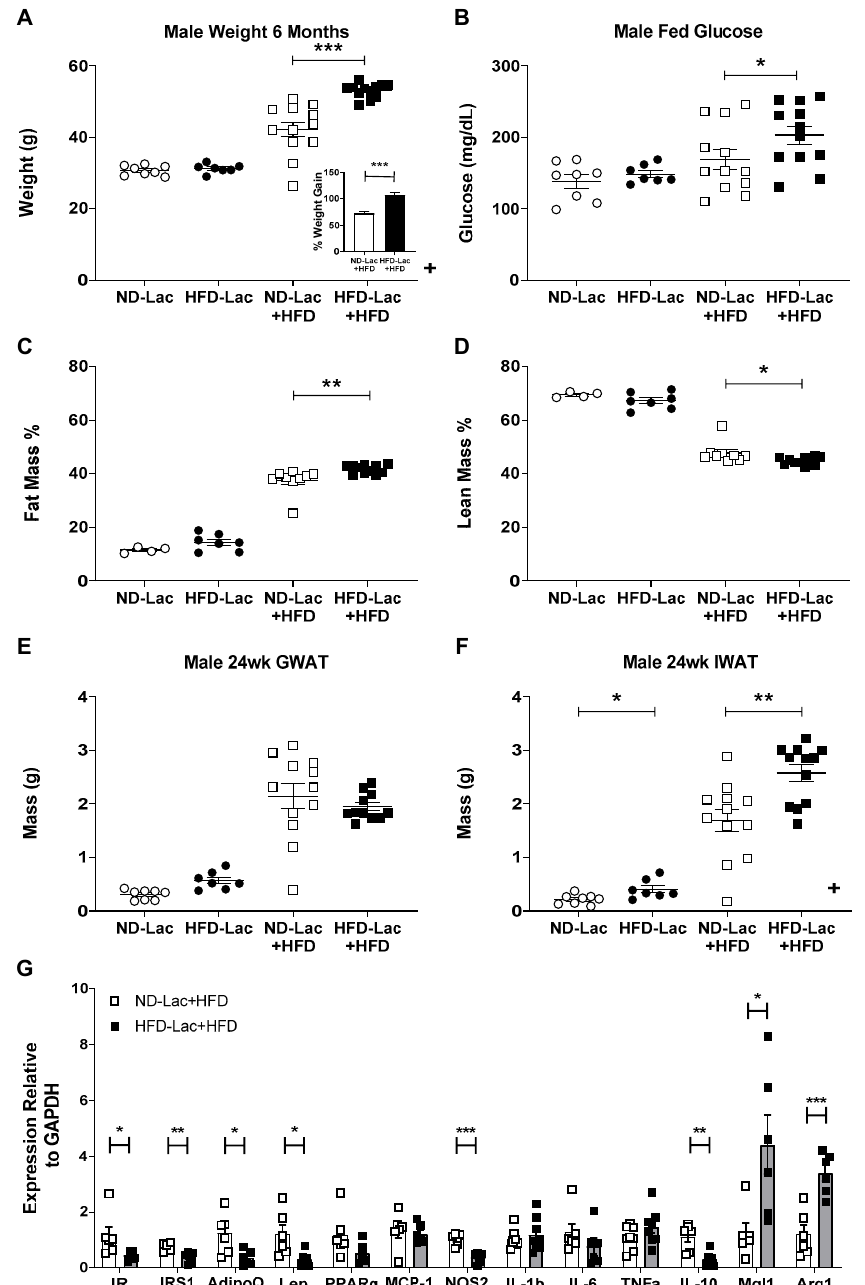
Figure 3. Male Lac-HFD offspring have increased fat mass. Data collected from males on either a normal diet or high-fat diet (+HFD) at six months of age. Weight, inset-percent weight gain over the course of HFD re-challenge ( A ). Fed glucose ( B ). Fat mass percentage ( C ). Lean mass percentage ( D ). Gonadal white adipose tissue (GWAT) weight ( E ). Inguinal white adipose tissue (IWAT) weight ( F ). qPCR on GWAT from males fed HFD ( G ). * p < 0.05, ** p < 0.01, *** p < 0.001. + indicates a significant interaction between lactation exposure and HFD